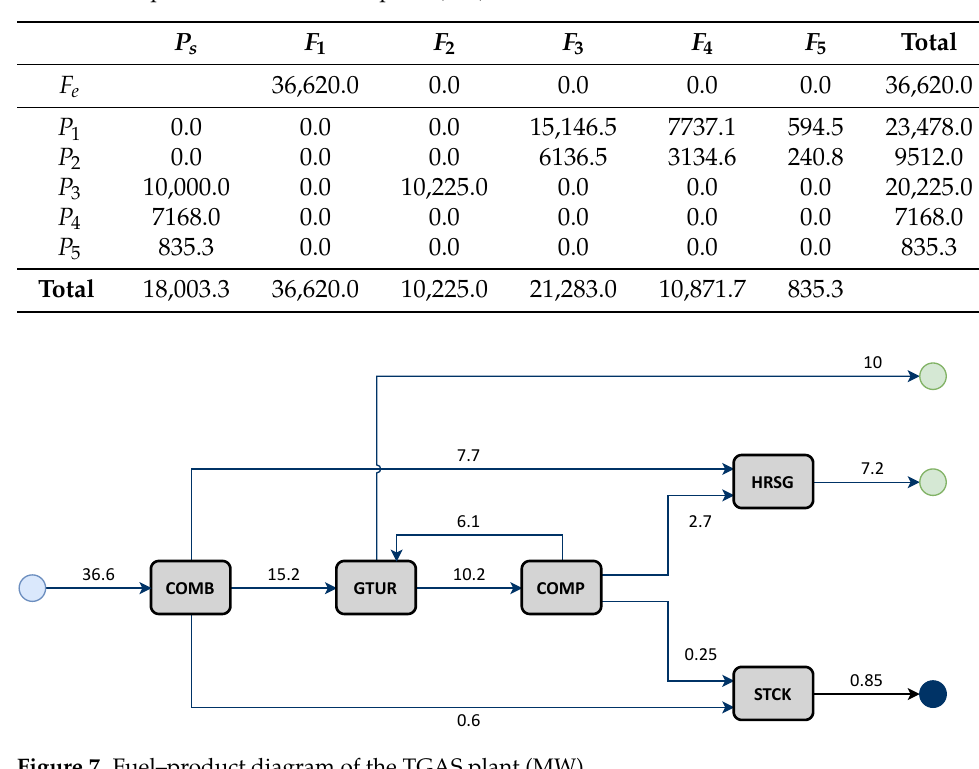
Figure 7. Fuel–product diagram of the TGAS plant